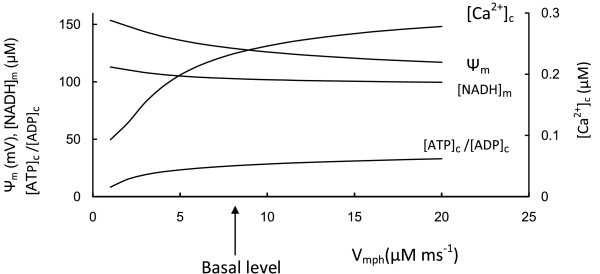
Model parameters in response to changes of the maximal rate of proton flux in F1F0 ATPase (Vmph). [Ca2+]c, Ψm, [ATP]c/[ADP]c and mitochondrial NADH concentration were calculated for medium glucose level (9 mM). Arrow corresponds to the basal Vmpe (Table 3).